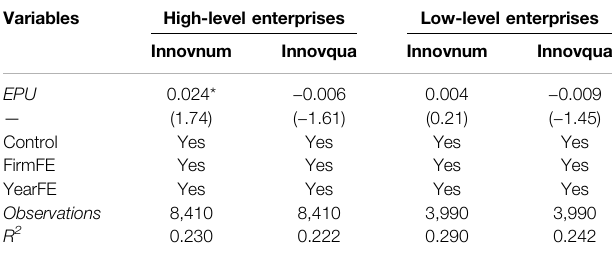
TABLE 8 | Heterogeneity of administrative